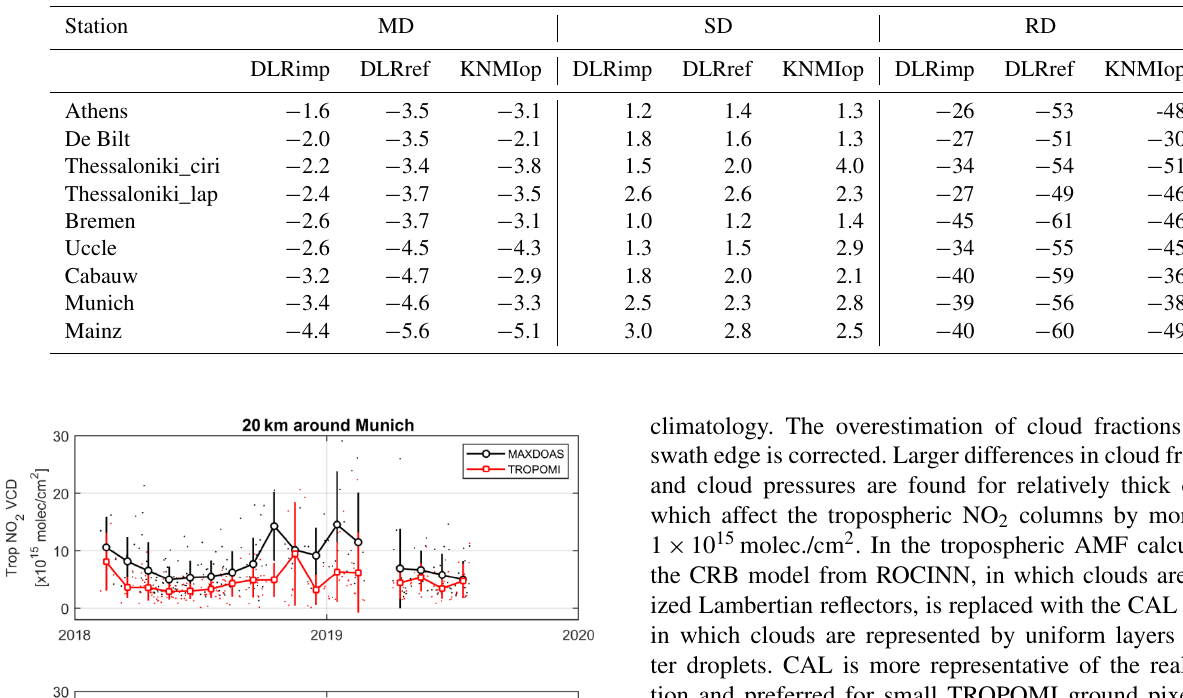
Table 6. Similar to Table 5 but for the mean difference (MD, SAT-GB in 1 × 10 15 molec./cm 2 ), standard deviation (SD, in 1 × 10 15 molec./cm 2 ), and relative difference (RD, in %) for the monthly TROPOMI tropospheric NO 2 product compared to MAX-DOAS data.